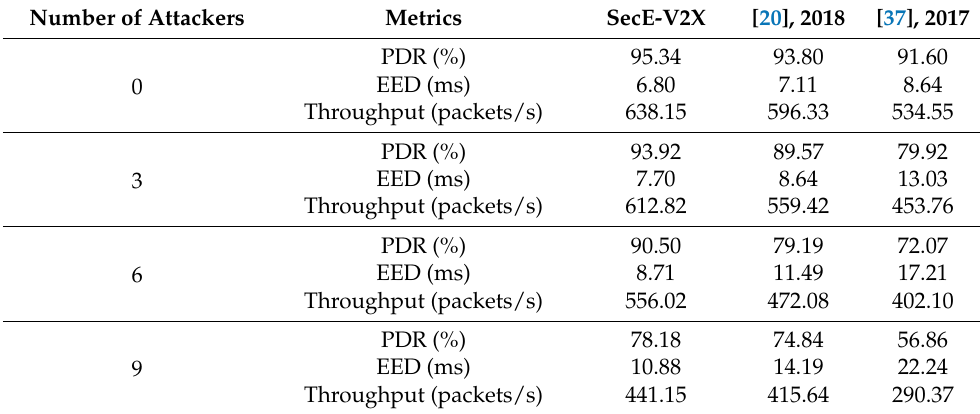
Table 7. Performance values comparison under Jellyfish reordering